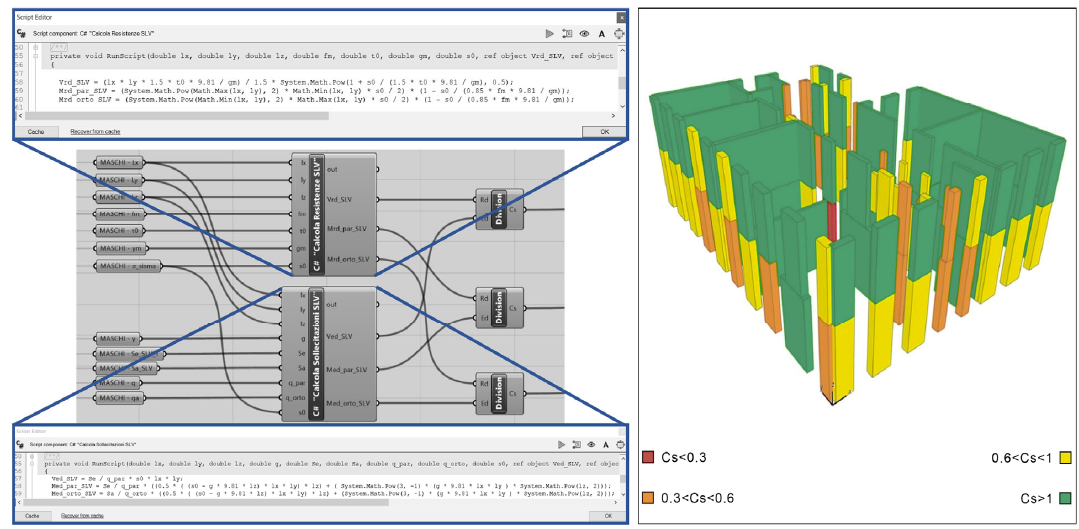
Figure 9. Code developed in Grasshopper to perform linear static analysis of an existing masonry structure and 3D representation of the results.